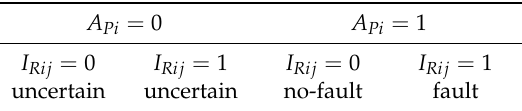
Table 1. Indication of two matrices.